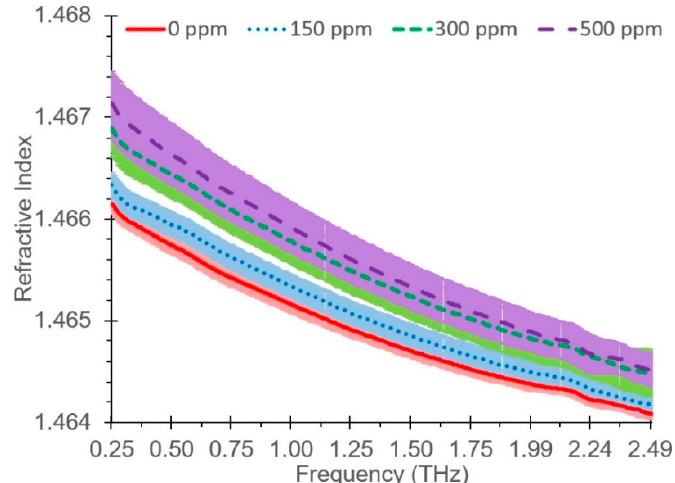
Figure 2. Mean refractive index of each of four glycol contamination levels of 5W-30 gasoline / diesel engine oil with 95% confidence intervals (for clarity when hidden, 95% confidence intervals are the same above and below the mean). Table 1. Partial refractive index and absorption coe ffi cient mean and standard deviation data